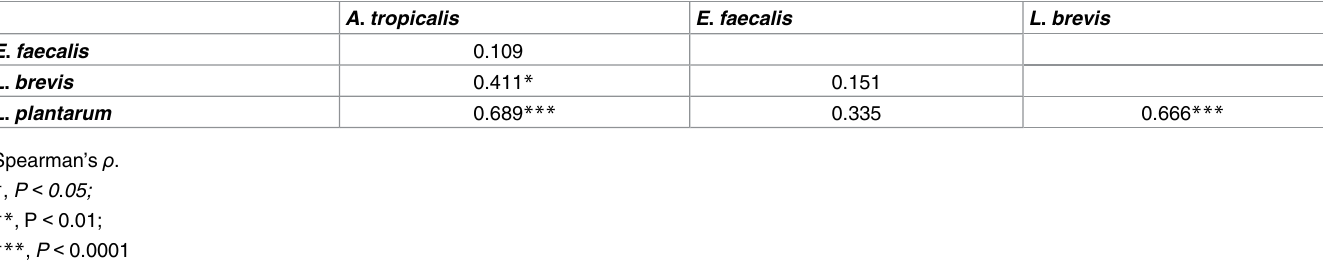
Bacterial population size was calculated as the ratio of bacterial DNA to fly DNA as measured with qPCR. Correlations were performed on the